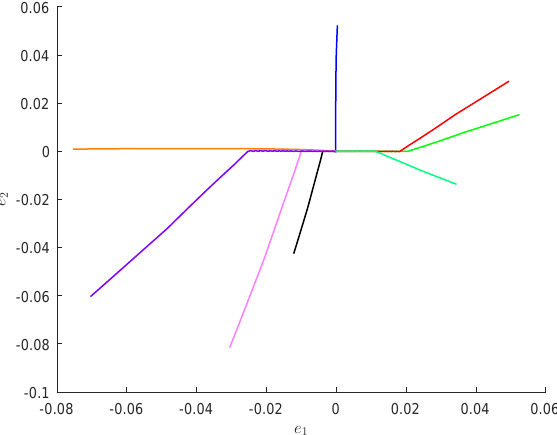
Figure 6. Phase trajectories of the errors e 1 and e 2 in Example 2, for 8 initial values (depicted with different colors). Best viewed in